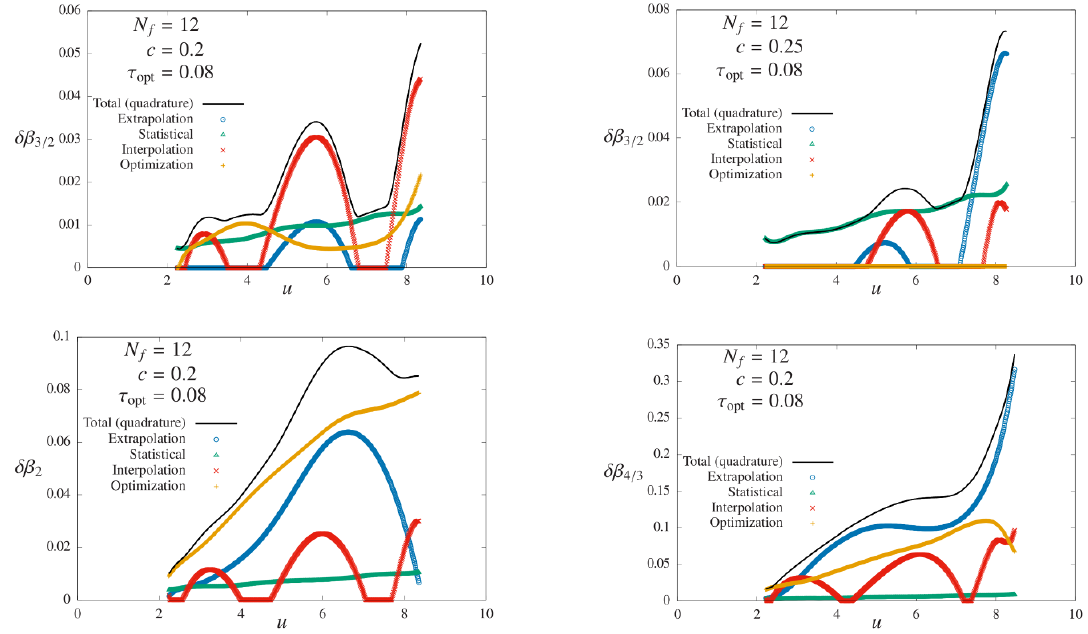
Figure 11 . Statistical and systematic ‘error budgets’ for four of our analyses, as functions of the renormalized coupling u . Each plot shows the statistical uncertainty and the three systematic uncertainties summarized in section 4, as well as their combination in quadrature. In the top row we compare s = 3 = 2 analyses with L (cid:21) 16 and c = 0 : 2 (left) vs. 0.25 (right). Even with L (cid:21) 16 the small c = 0 : 2 introduces non-zero optimization uncertainties as in accordance with (cid:12)gure 10, though these remain comparable to the statistical uncertainties. When L = 12 is included the